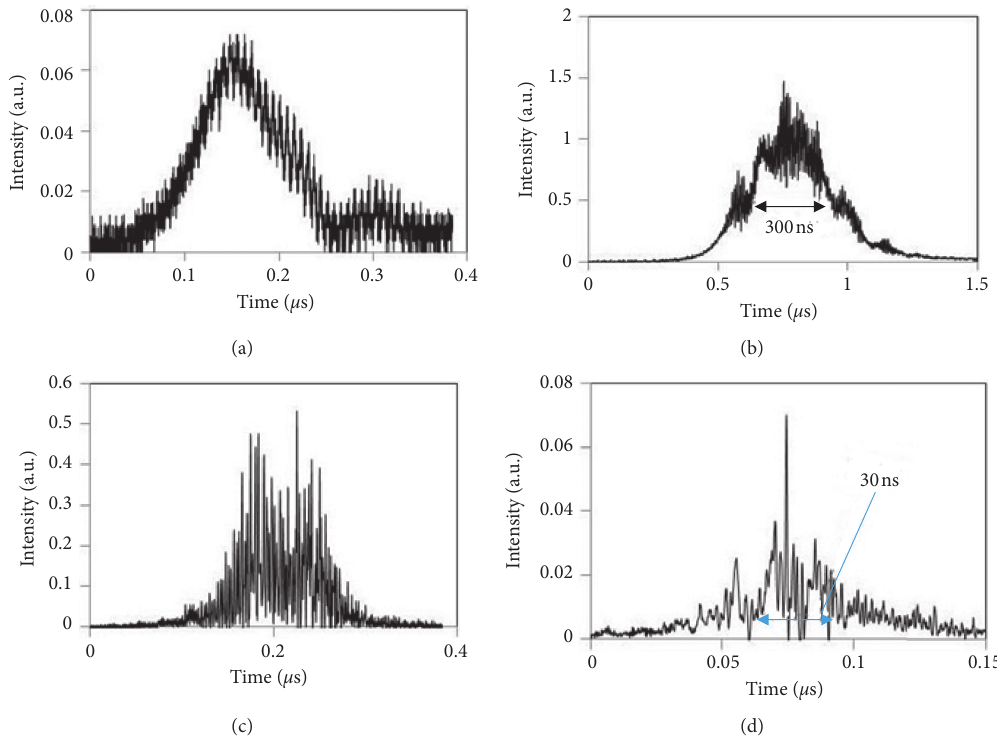
Figure 7: Q-switched and mode-locked pulses (cavity length 20 cm, SESAM R � 86%): (a) Cr 4+ :YAG T � 95%; (b) Cr 4+ :YAG T � 90%; (c) Cr 4+ :YAG T � 80%; (d) Cr 4+ :YAG T � 70%.